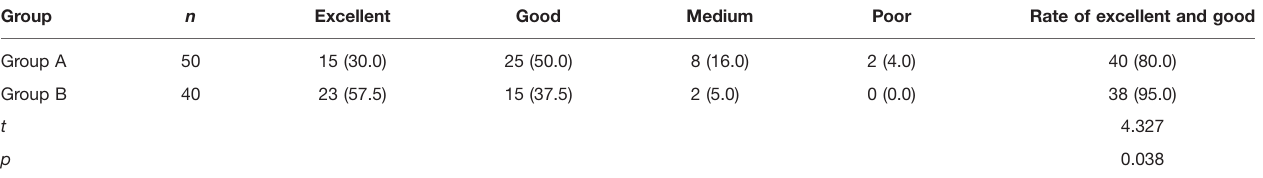
TABLE 4 | Comparison of hip joint function recovery between two groups of patients [ n (%)].